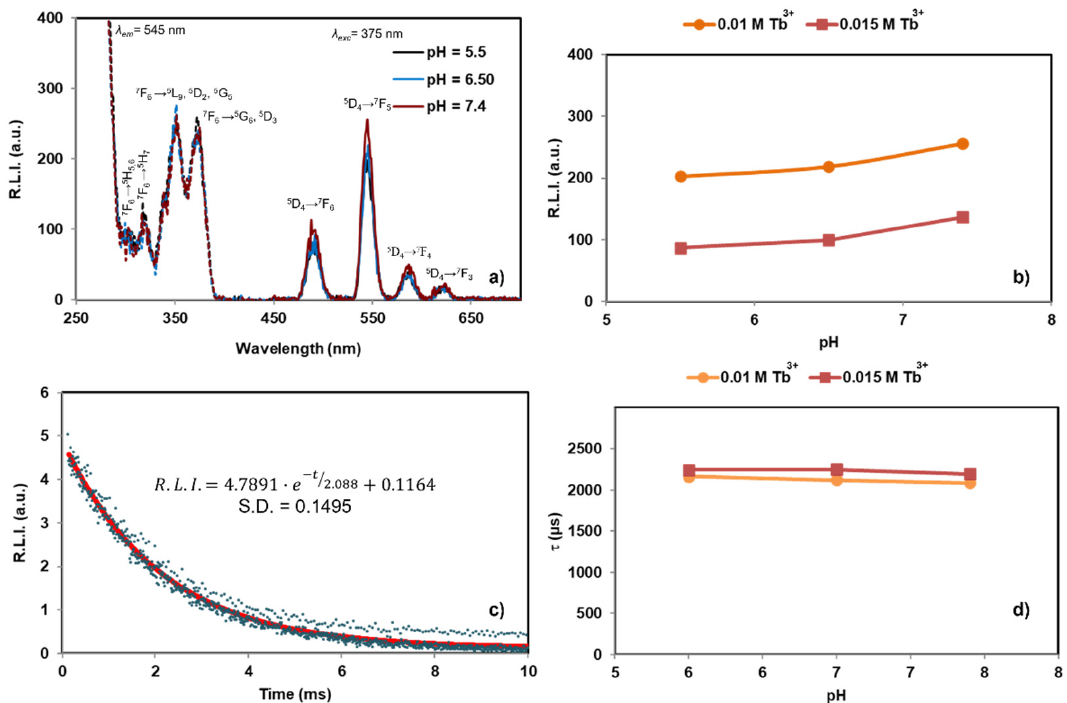
Figure 7. Luminescence properties of samples ( x = 0.015 M Tb 3+ , t = 96 h) dispersed in aqueous media at 25 °C: ( a ) excitation (dashed line) and emission (solid line) spectra for samples x = 0.015 M Tb 3+ at different pHs; ( b ) evolution of R.L.I. with pH; ( c ) luminescence decay curve of sample x = 0.015 M Tb 3+ at pH = 7.4; and ( d ) evolution of τ versus pH.